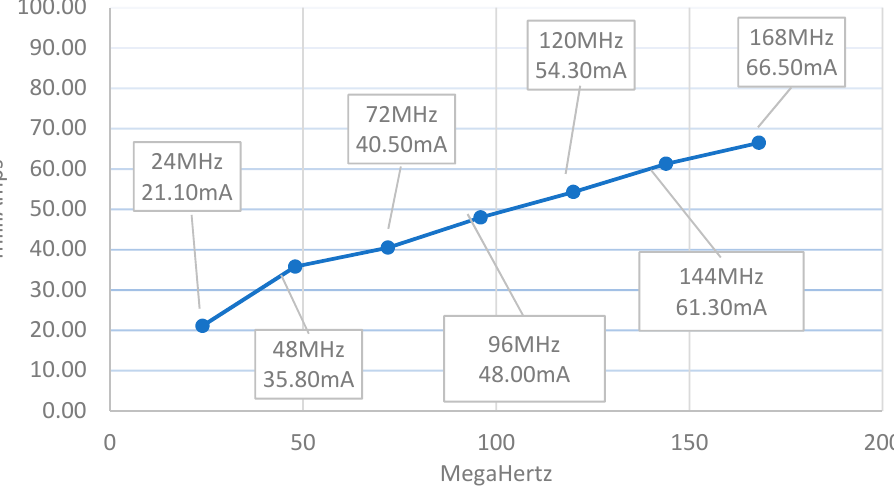
Figure 2. Reduction in clock frequency results in a reduction in current drawn [16]. Table 1. Selected voltage characteristics of GPS and dust sensors [16].